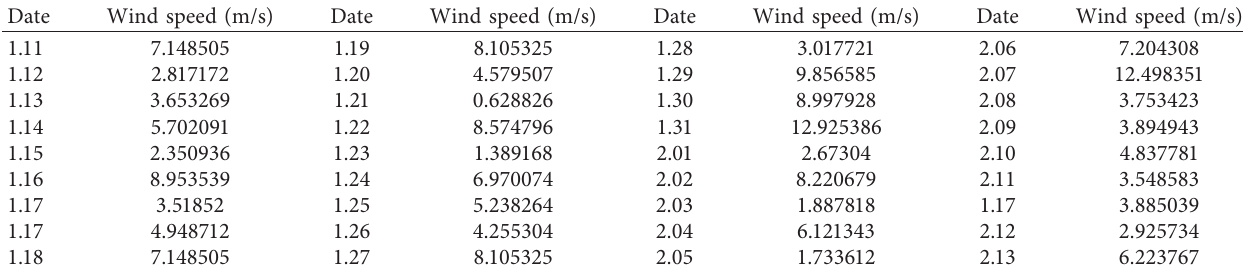
Table 13: Pudong Airport wind speed change during the period from January 11, 2019 to February 13, 2019.